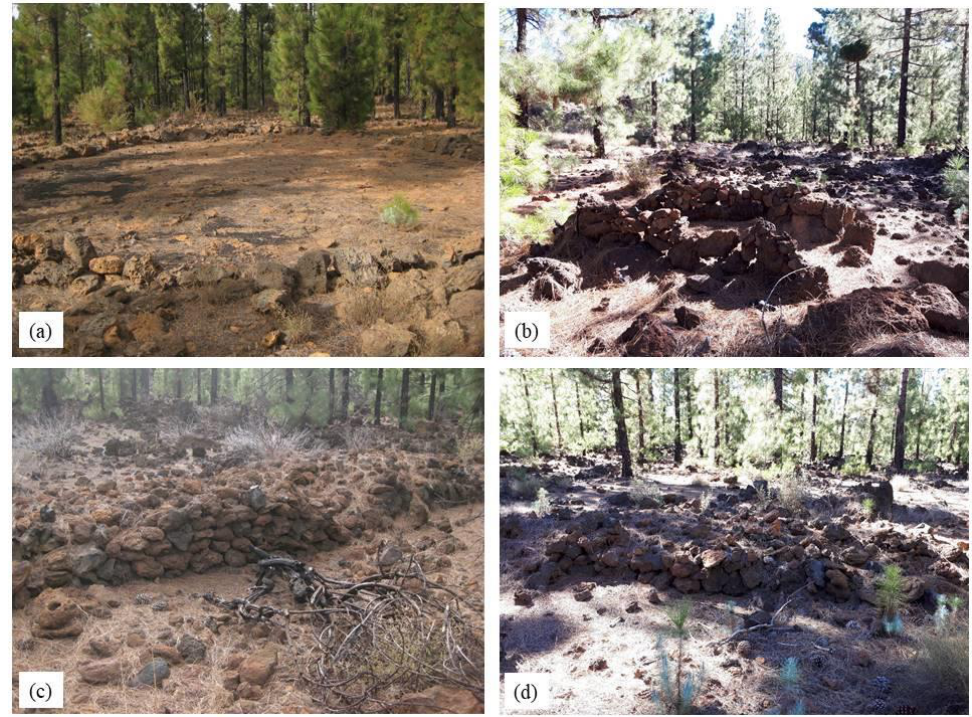
Figure 12. Elements representing the cultural heritage of the landscape: ( a ) old threshing floor ( b ) old dry-stone structures ( c , d ) remains of walls in old farming areas. Source: authors.